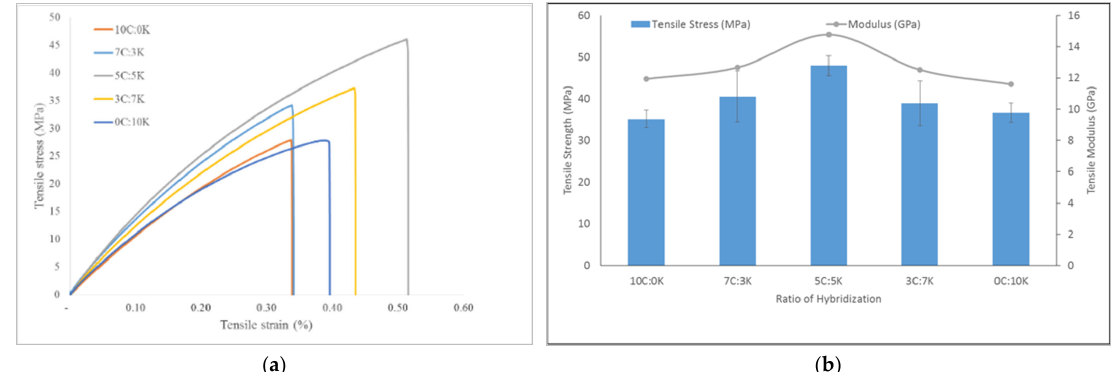
Figure 4. ( a ) Tensile stress vs. strain curve, ( b ) tensile strength and modulus, of hybridization between C and K fibers.